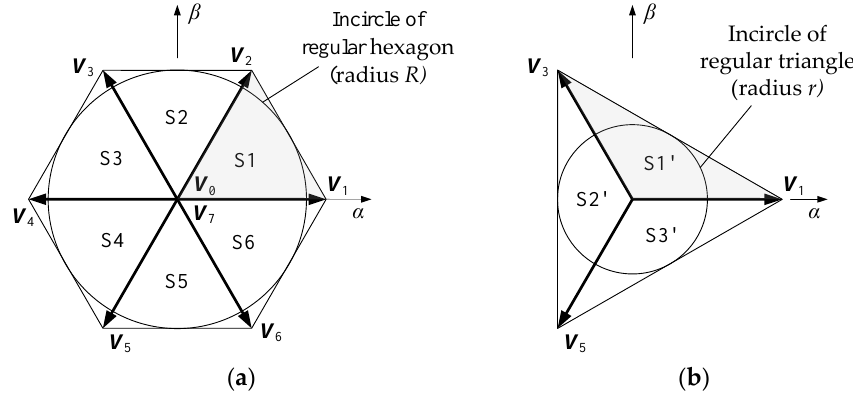
Figure 2. Conventional SVPWM and SVPWM by only using three non-zero vectors. ( a ) Conventional SVPWM; ( b ) SVPWM by only using three non-zero vectors.